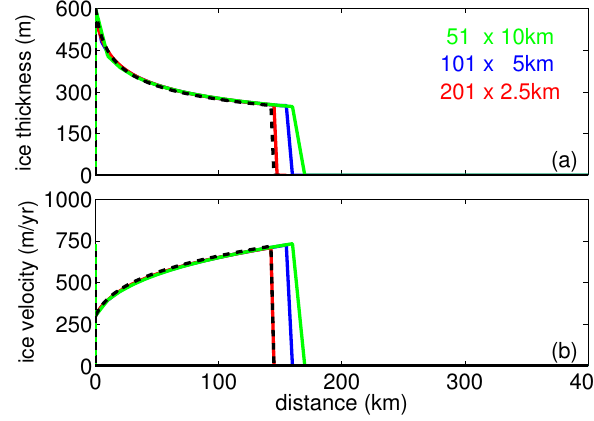
Fig. 5. Steady-state flow-line ice thickness and velocity profiles in lateral view calculated with different resolution but constant size of computational domain. Calving front position (145km) and ter- minal velocity (720m / yr) as expected from the analytical solution with constant ice hardness for 250m terminal ice thickness are shown as black dashed line. Adaptive time steps and variant 1 of residual ice treatment are